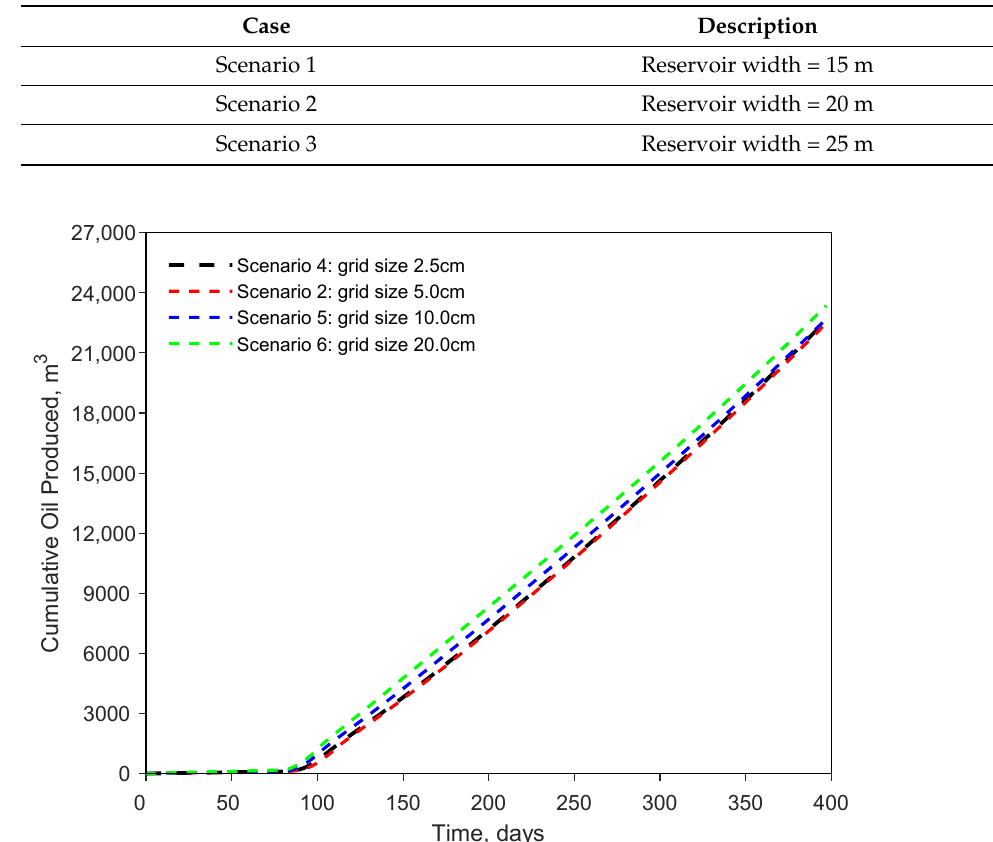
Table 3. Summary of scenarios for grid size selection. Table 2. Scenarios demonstrating the impact of reservoir width on SAGD ramp-up phase.